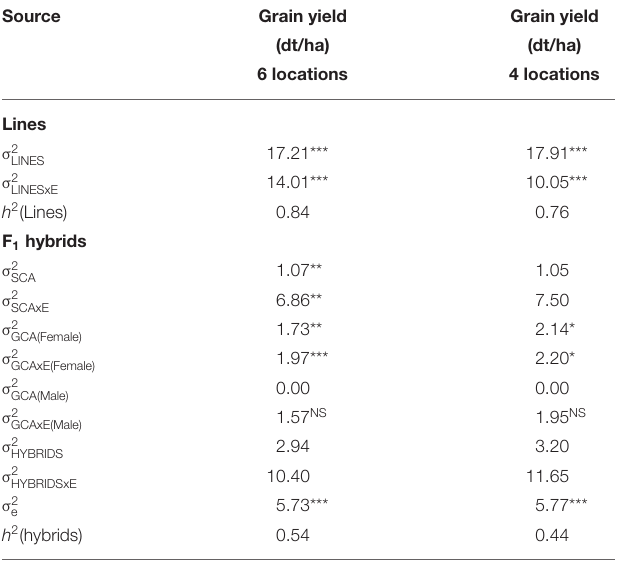
females with environments and performed a cluster